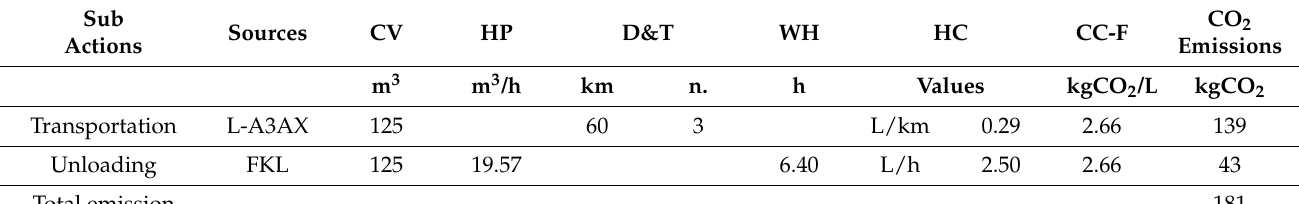
Table 10. Emissions during the transport to market (city of Rome) of the SFCT products. Legend:L-